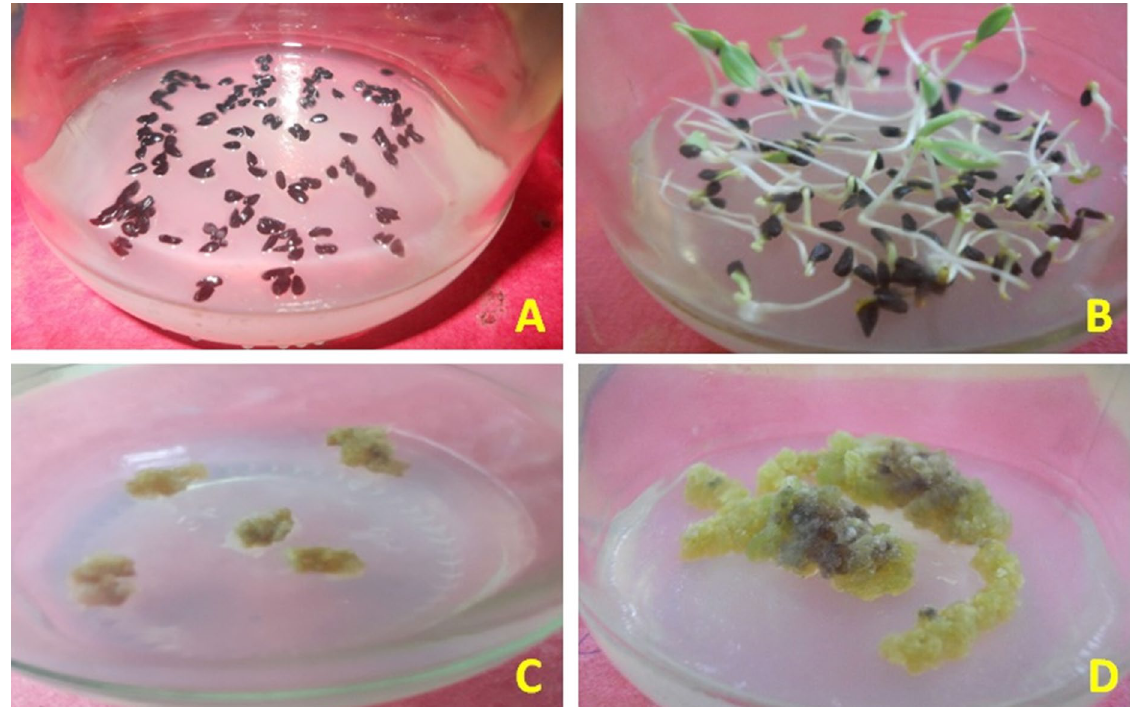
Figure 1. NS seed germination on MS medium and callus formation using plant tissue culture technique. ( A ) NS seeds on MS media; ( B ) NS seedlings; ( C ) Callus of NS in MS media supplemented 2,4-D; ( D ) Sodium azide treatment on NS Callus (n =